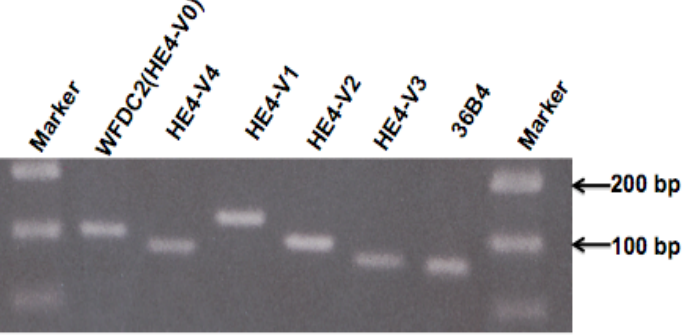
Figure 2. Gel electrophoresis of real-time PCR products. Real-time PCR products of the five HE4 transcript variants are obtained from normal endometrial specimen, and separated in 2% agarose gel. The real-time PCR product size for each variant was: for HE4